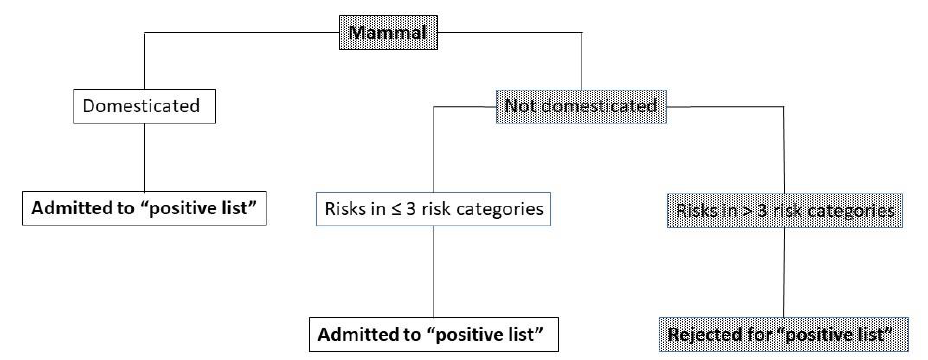
Figure 2. Decision tree for the admittance to the domestic and hobby animals list (“positive list”. The arched text represents the advisory committee’s assessment of the